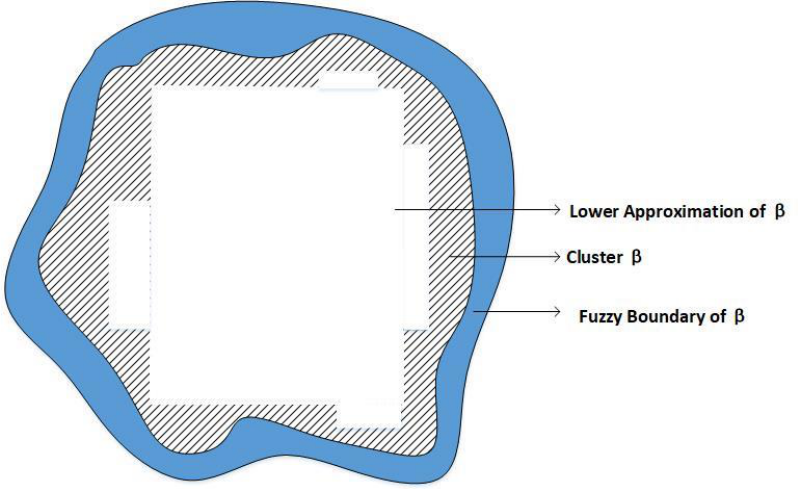
Figure 4. Cluster  and its lower approximation region and fuzzy boundary region. Figure 4. Cluster β and its lower approximation region and fuzzy boundary